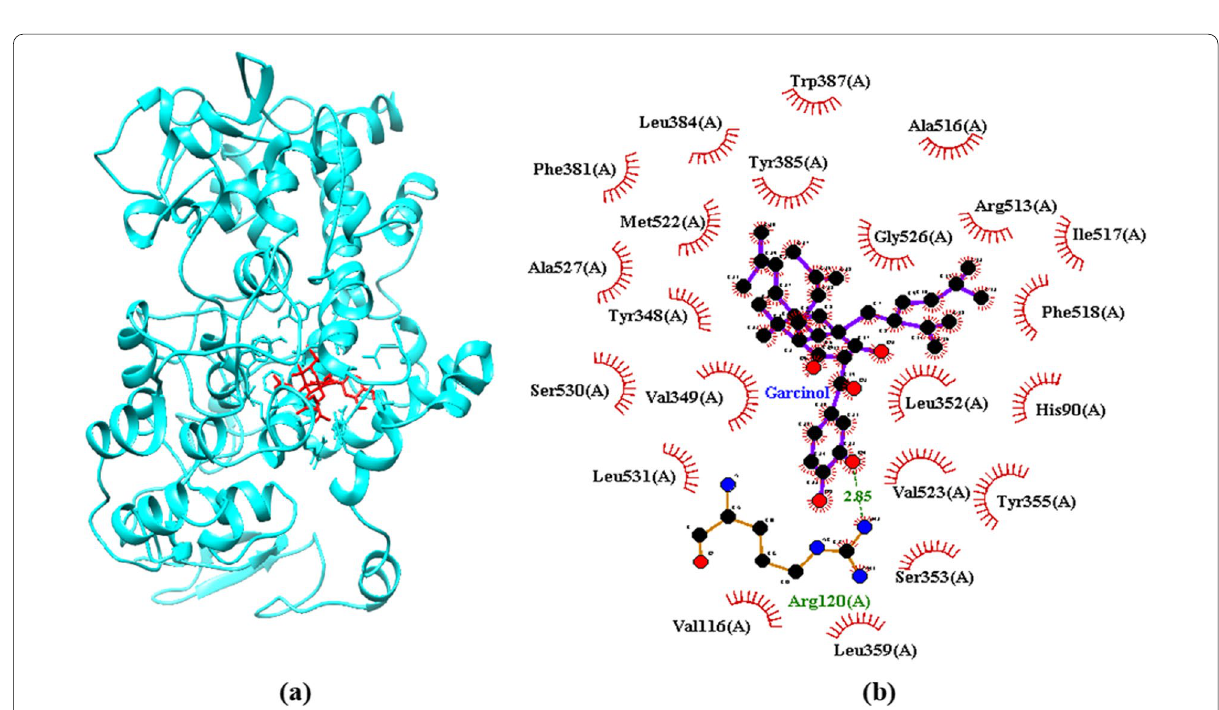
Fig. 10 Docking images of protein (COX-2) and ligand (Garcinol). a Shows the 3D interaction between garcinol (red) and COX-2(blue). b LigPlot image showing the H-bond interactions (Arg120) and hydrophobic interactions (Trp387, Ala516, Arg513, Tyr385, Leu384, Gly526, Ile517, + Phe518, His90, Leu352, Val523, Ser353, Leu359, Val116, Leu531, Ser530, Val349, Tyr348, Ala527, Met522, Phe381) between Garcinol and